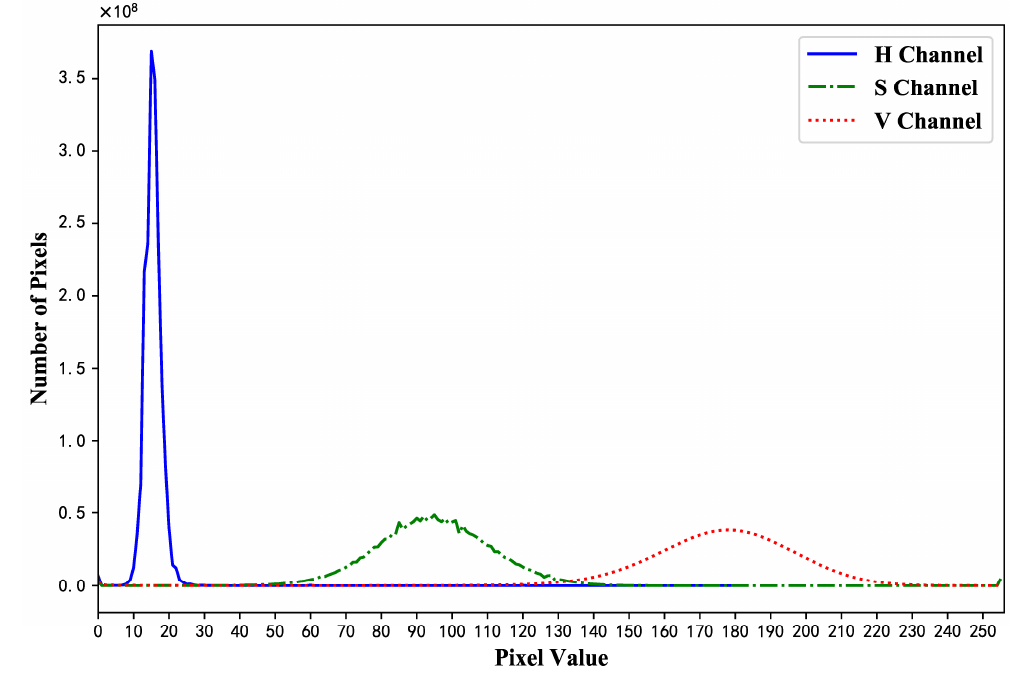
Figure 8. The numbers of pixels with each value in the H, S, and V